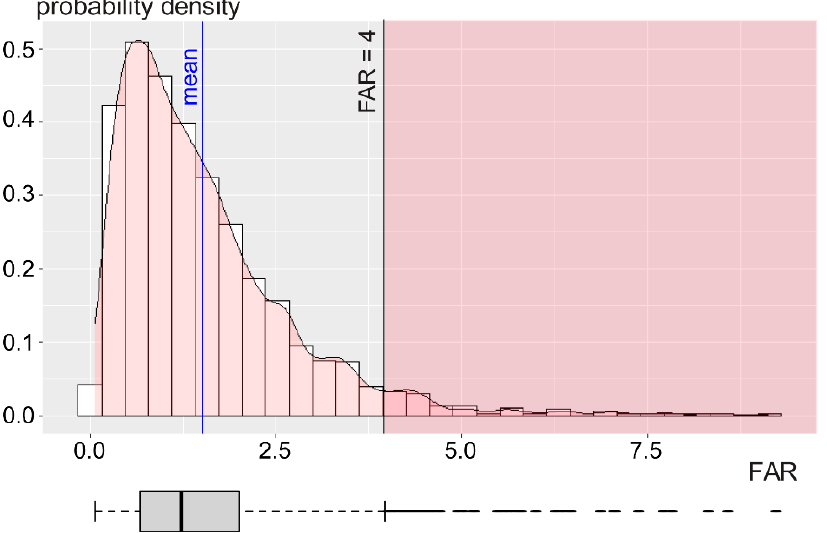
Figure 4. Population density of the FAR metric with original mean line (blue) and removed portion of iteration cases (where FAR > 4). A box plot of the FAR dataset is included at the bottom.